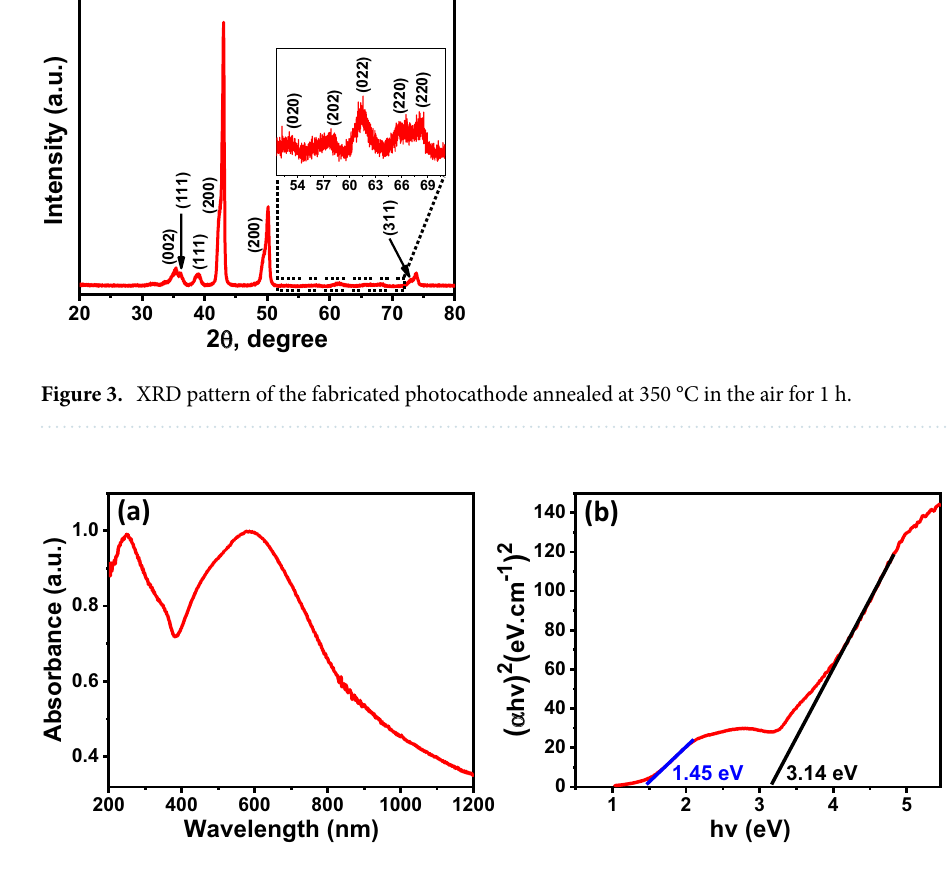
Figure 4. ( a ) UV–Vis absorption spectra and ( b ) Tauc plot of the fabricated photocathode annealed at 350 °C for 1 h in